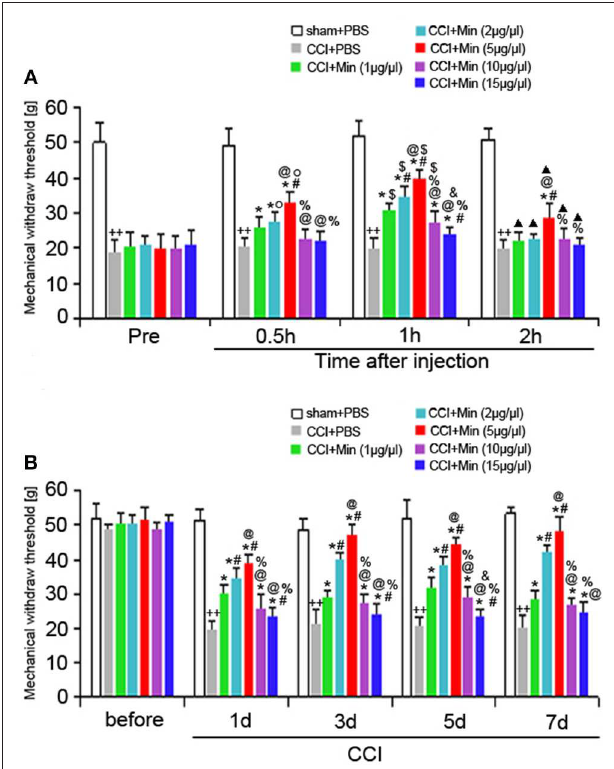
FIGURE 1 | MWT was determined in different groups. All values represent mean ± SD ( n = 8). (A) Decreased MWT was exhibited in the CCI rats on day 1 after surgery compared to sham rats ( ++ P < 0.01). Compared with CCI rats, minocycline (1, 2, 5, 10, and 15 µ g/ µ l) treatment exerted anti-hyperalgesic effects (* P < 0.05). Minocycline treatment showed obvious increased MWT (vs. 1 µ g/ µ l: # P < 0.05; vs. 2 µ g/ µ l: @ P < 0.05; vs. 5 µ g/ µ l: % P < 0.05; vs. 10 µ g/ µ l: & P < 0.05). Greater analgesic effect of minocycline occurs 1h after its administration (vs. Pre: O P < 0.05; vs. 30 min: $ P < 0.05; vs. 1 h: N P < 0.05); (B) The MWT was measured at 1, 3, 5, and 7 days after surgery. Decreased MWT was exhibited in the CCI rats on days 1, 3, 5, and 7 after nerve injury compared to sham rats ( ++ P < 0.01). Compared with CCI rats, minocycline (1, 2, 5, 10, and 15 µ g/ µ l) treatment exerted anti-hyperalgesic effects (* P < 0.05). Minocycline treatment showed the more obvious increase in MWT (vs. 1 µ g/ µ l: # P < 0.05; vs. 2 µ g/ µ l: @ P < 0.05; vs. 5 µ g/ µ l: % P < 0.05; vs. 10 µ g/ µ l: & P <